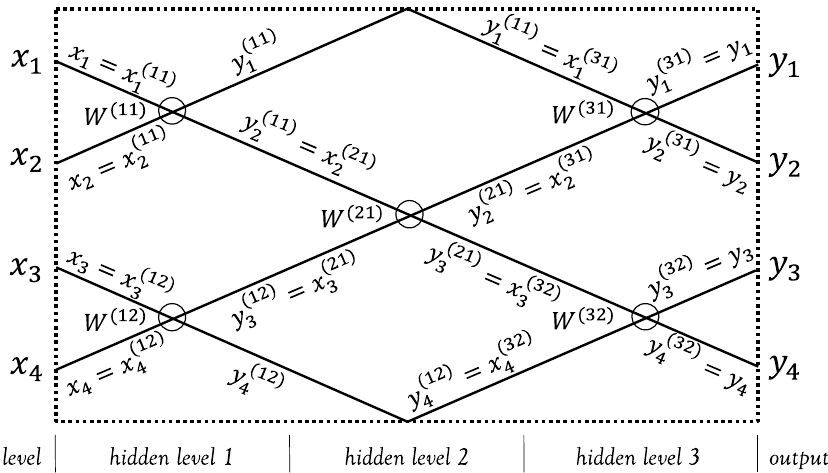
Figure 3. Structural scheme of the SNN used as an episodic memory. W represents the computational weight of the node. W (1) is the computational weight relative to the node of the first neuron in Layer 1; W (2) is the computational weight relative to the node of the second neuron in Layer 2; W (3) is the computational weight relative to the node of the neuron in Layer 2; W (4) is the computational weight relative to the node of the first neuron in Layer 3; W (5) is the computational weight relative to the node of the first neuron in Layer 3. The inputs at the entrance to the network are x i while the signals at the end of the whole processing are y i .